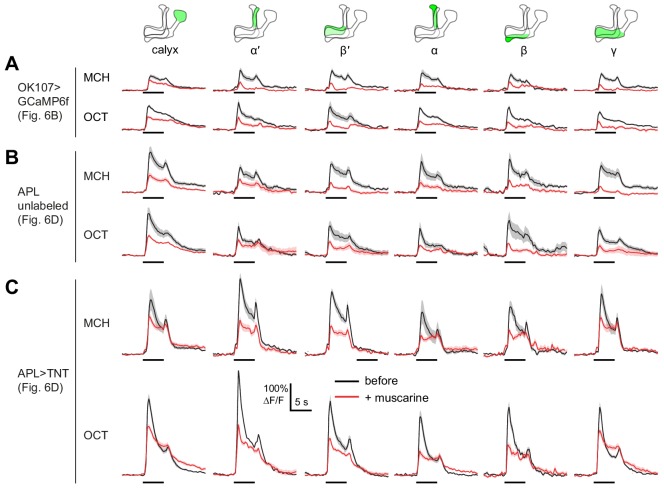
KC odor responses are decreased by muscarine — all traces.Extended data for Figure 5. Odor responses in OK107-GAL4 > GCaMP6f flies (A), control APL unlabeled hemispheres (B), and APL >TNT hemispheres (C), before (black) and after (red) adding 10 µM muscarine in the bath. Data are mean (solid line) ± SEM (shaded area); diagrams illustrate which region of the MB was analyzed; horizontal lines indicate the odor pulse. These are the traces for the summary data shown in Figure 5B,D.